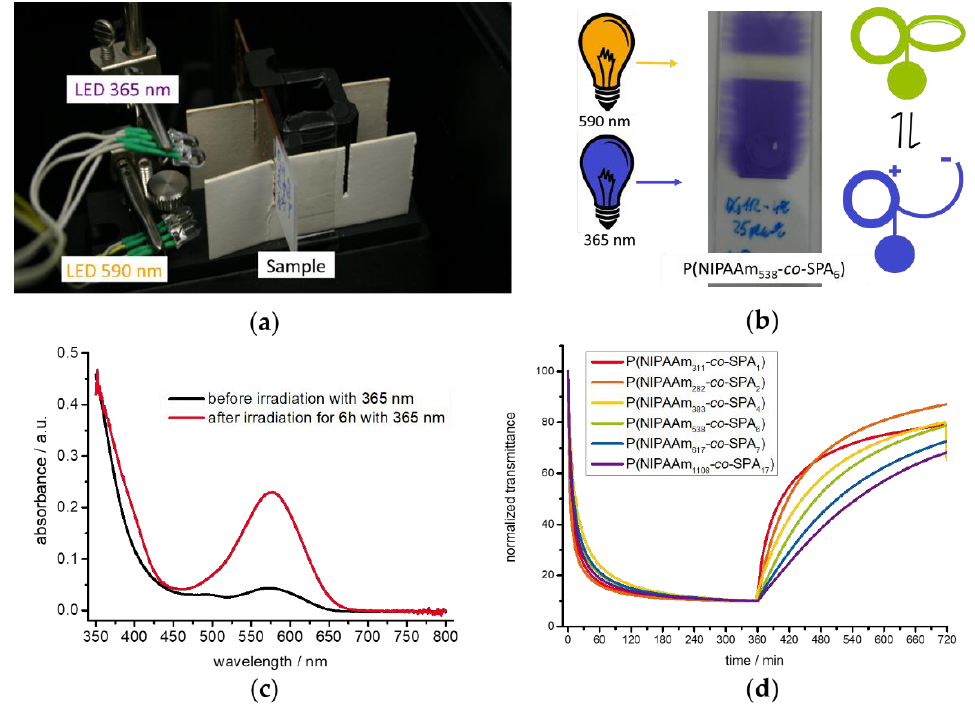
Figure 3. ( a ) Custom-made setup used to measure the transmittance of the copolymer films during irradiation at 365 or 590 nm; ( b ) P(NIPAAm 538 - co -SPA 6 ) film on a glass slide after partial irradiation; ( c ) Absorption spectra of P(NIPAAm 282 - co -SPA 2 ) in the solid state before irradiation at 365 nm, and after reaching equilibrium after 6 h; ( d ) Normalized transmittance after one switching cycle of P(NIPAAm- co -SPA) containing varying amounts of SPA. The absorption was monitored at 550 nm after irradiation at 365 and 590 nm for 6 h each.